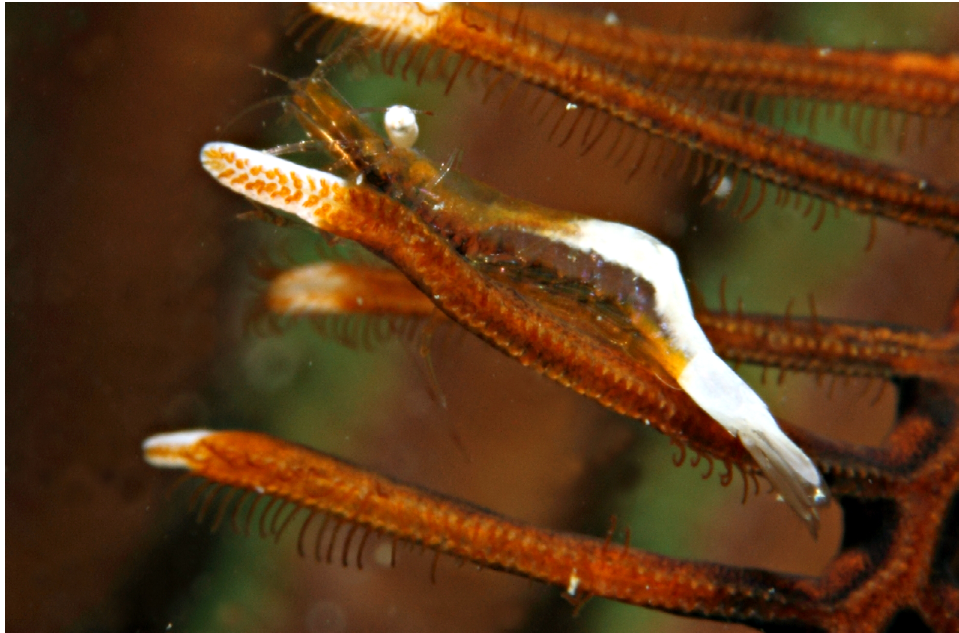
Figure 4. Male of Periclimenes crinoidalis (CL 1.58 mm), associated with the crinoid Nemaster cf. grandis , in Chichiriviche de la Costa, Vargas State,